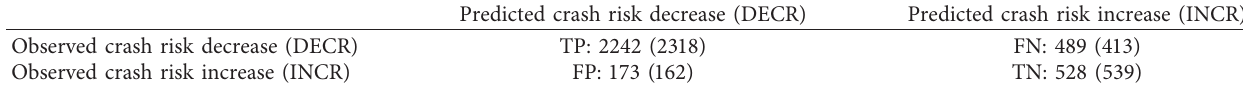
Figure 5: The BN model with flow-level variables for measuring rear-end crash risk variation. Table 4: BN classification confusion matrix for the dataset of G50.